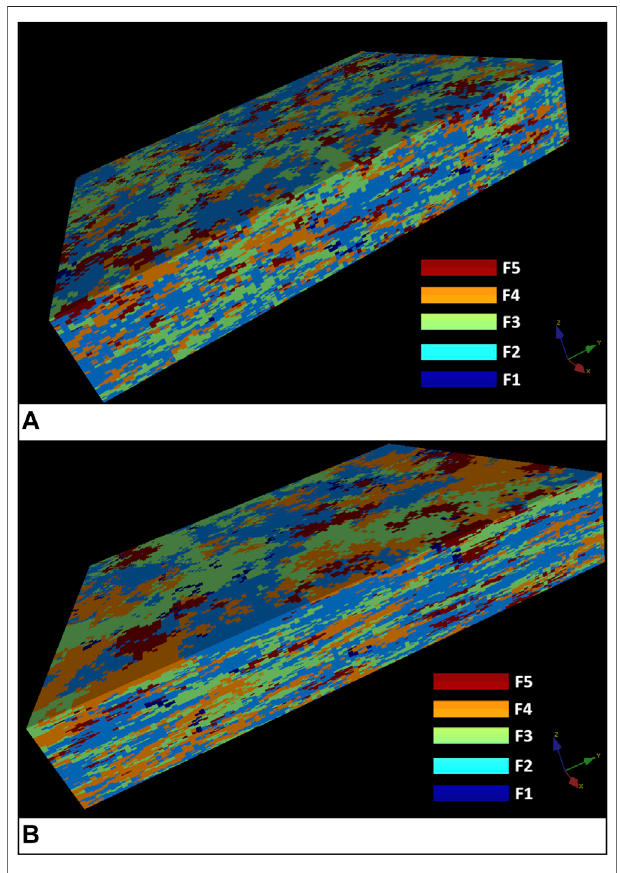
FIGURE9 | 3D view ofarealization generated byusing the experimental proportions and (A) median indicator krigingand (B) multiple indicator kriging.